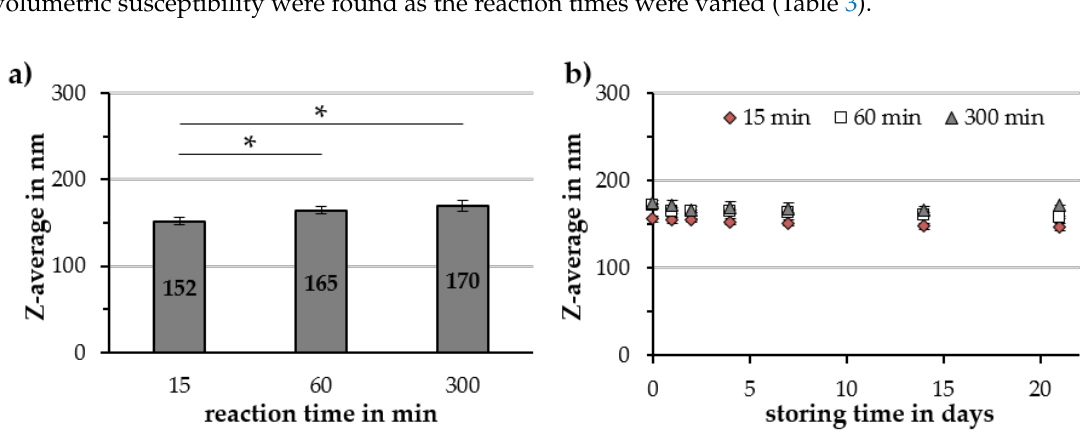
Figure 6. Influence of the reaction time during Cit-Au-SPION synthesis on ( a ) the Z-average and ( b ) the particle stability during 21 days of storage in a fridge. Statistically significant changes are marked with * for p < 0.05.